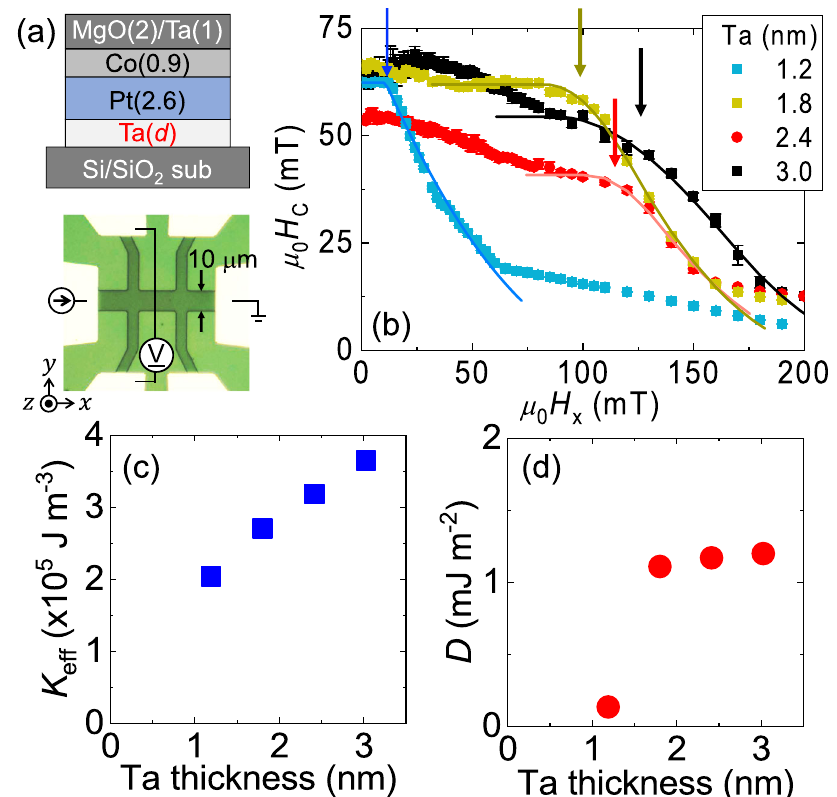
Fig. 3 Experimental determination of the DM interaction. a Schematic illustration of the fi lm structure, an optical microscope image of a representative device and a de fi nition of the coordinate axes. b Switching fi eld H c plotted as a function of H x for Hall bars made from heterostructures with different Ta seed layer thickness ( d ). The vertical arrows indicate H DM obtained by fi tting the data with model calculations 24 . The solid lines show the fi tting results. c , d d dependence of the effective perpendicular magnetic anisotropy energy ( K eff ) ( c ) and the DM exchange constant ( D ) ( d